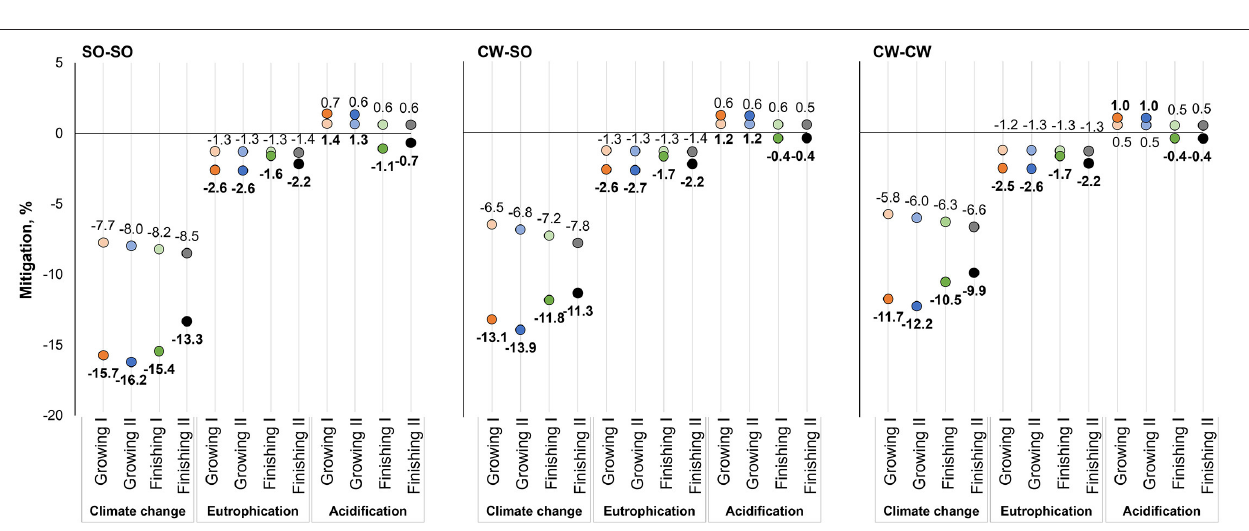
FIGURE 3 | Potential environmental impact mitigation associated with the production of growing-finishing pig feeds, considering energy savings from two energy matrices (45 kcal of ME/kg of feed, light circles; 90 kcal of ME/kg of feed, dark circles) released by β -mannanase supplementation in different grain production scenarios; SO-SO, Soybean and corn produced in Southern Brazil; CW-SO, Soybean produced in Central-West Brazil and corn produced in Southern Brazil; CW-CW, Soybean and corn produced in Central-West